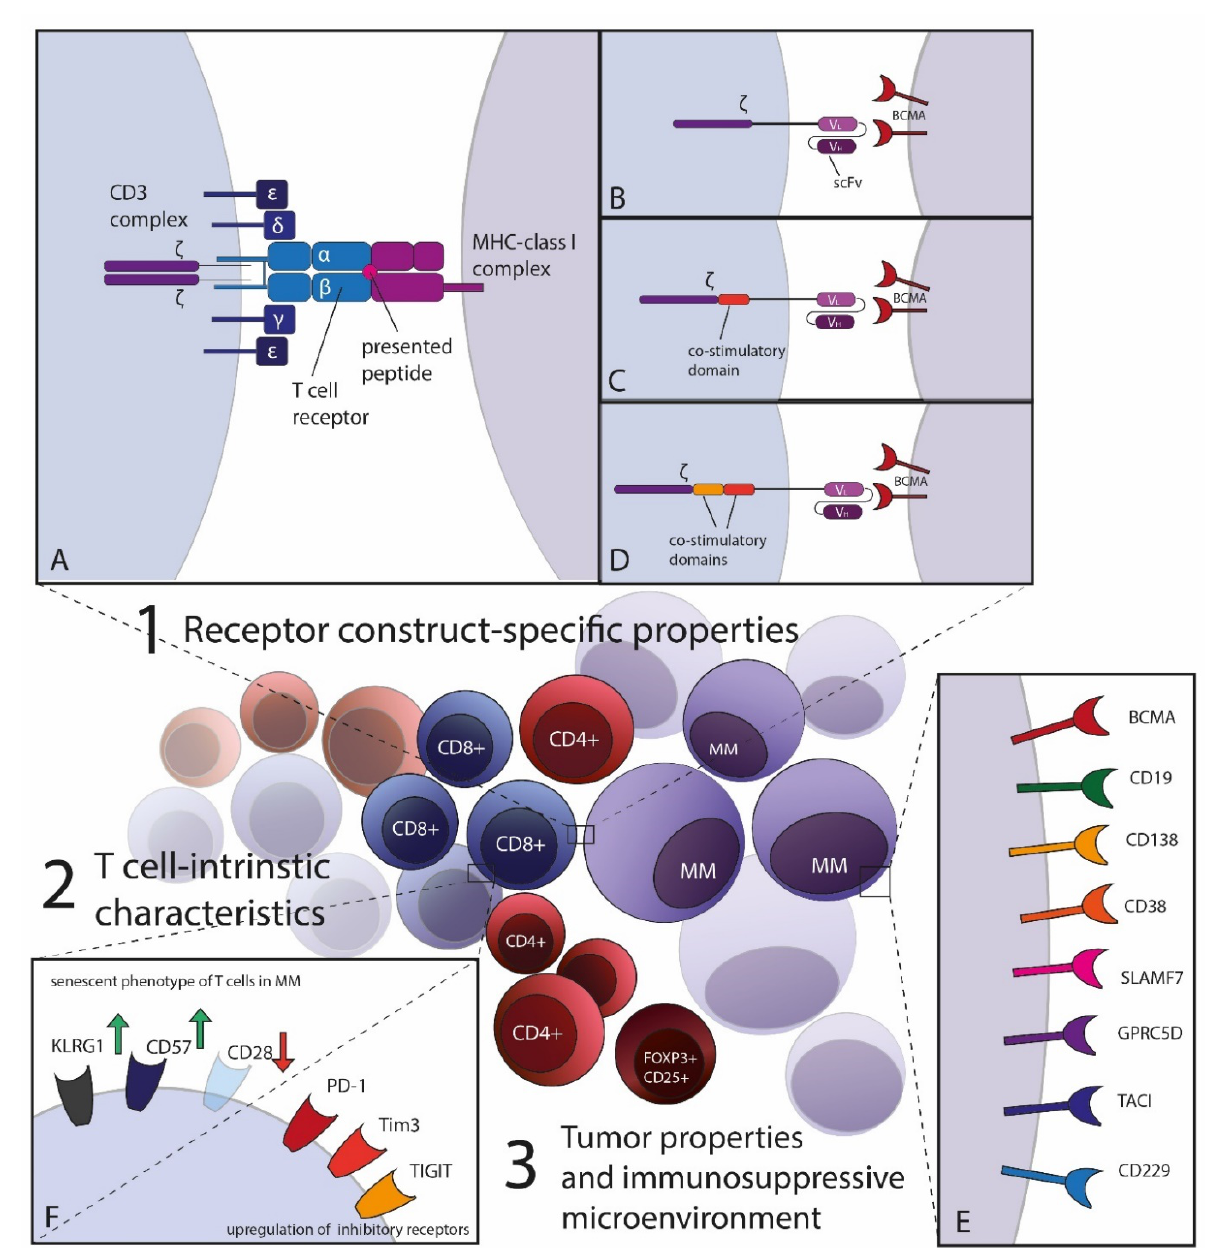
Figure 1. Engineering CAR- or TCR-transgenic T cells in MM. Transgenic CD8+ (blue) and CD4+ (red) T cells are shown encountering MM cells (violet). As an exemplary immunosuppressive element for ACT in MM a FOXP3 + CD25 + Treg cell (dark red) is present amongst the cells. The levels on which T cell engineering can take place (1–3) are indicated. The genetically transferred constructs are depicted schematically in proximity to their target structures—TCR associated with the chains of the CD3-complex ( A ) or CAR (1st ( B ), 2nd ( C ) and 3rd ( D ) generation)—as well as different potential surface targets on MM cells ( E ). The typical surface expression of senescence markers in T cells for MM as well as the upregulation of inhibitory markers is also depicted as a T cell-intrinsic characteristic ( F ).